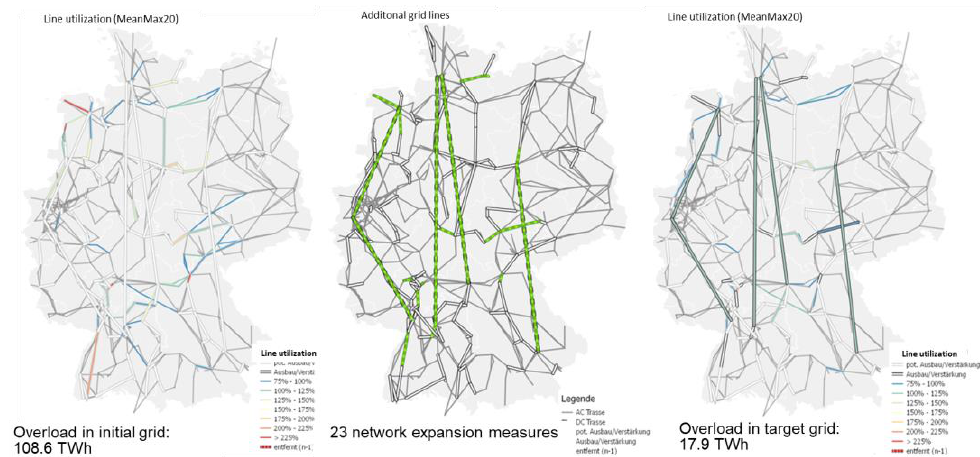
Figure 5. Results of iterative grid expansion for socio-ecologic distribution scenario. The maximum utilization rates occurring on the individual lines of the own target network in the scenario “ equally distributed ” are comparable with those in the economic scenario “ NEP B 2030 ” . In comparison to the NEP target network, however, 93 lines show an overload greater than 100% and the maximum overload on a single line is also higher than the NEP target network (270%) at 327%. Compared to the economic target network, the maximum thermal overload in the equally distributed target network is higher and affects three times as many lines.